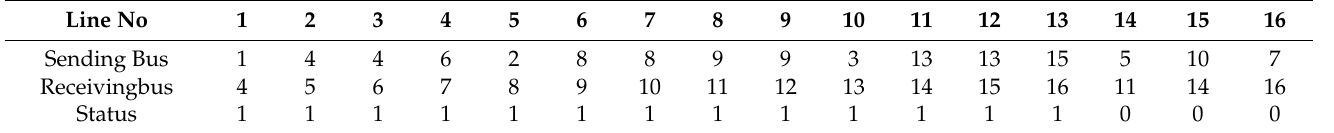
Table 1. The 16-bus distribution network is represented in binary (Bits).